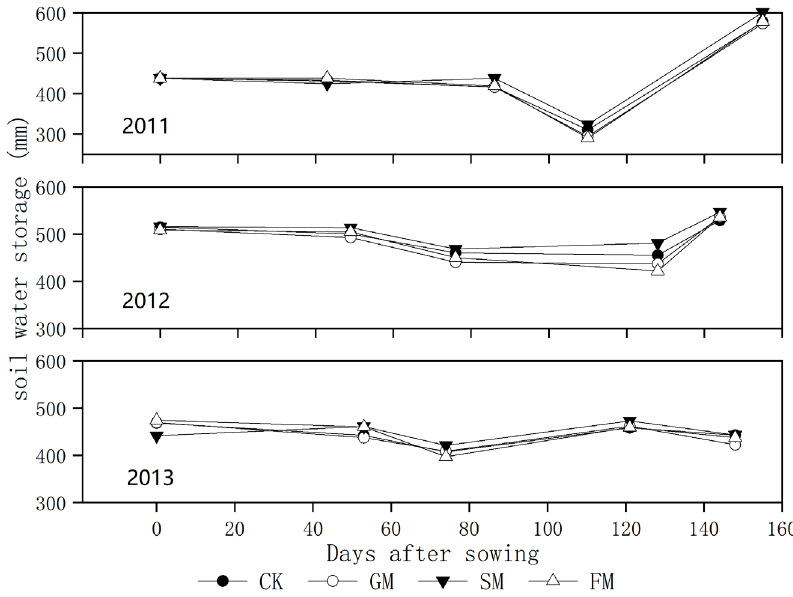
Figure 3. Soil water storage in the 0–200 cm soil layers in 2011, 2012, and 2013. When the lowest value of soil water storage occurred (i.e., R3 in 2011, R5 in 2012, and VT in 2013), the replenishment of the water stored in the soil by rainfall gradually increased with the increase in the amount of precipitation during the late growth period of the maize.